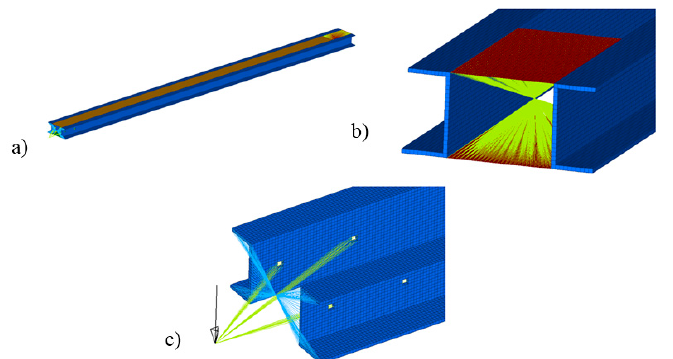
Figure 3. FE model design for the Gauge procedure: ( a ) complete FE model; ( b ) restrain application area; ( c ) load application and beam tip behavior monitoring points.